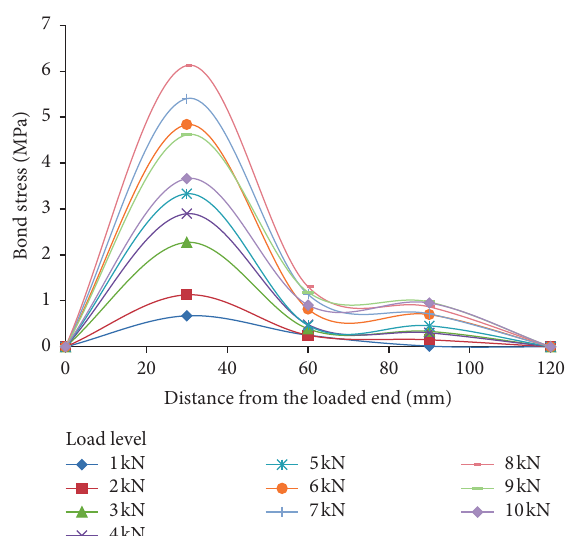
Figure 9: Bond stress distribution for plain bar-reinforced